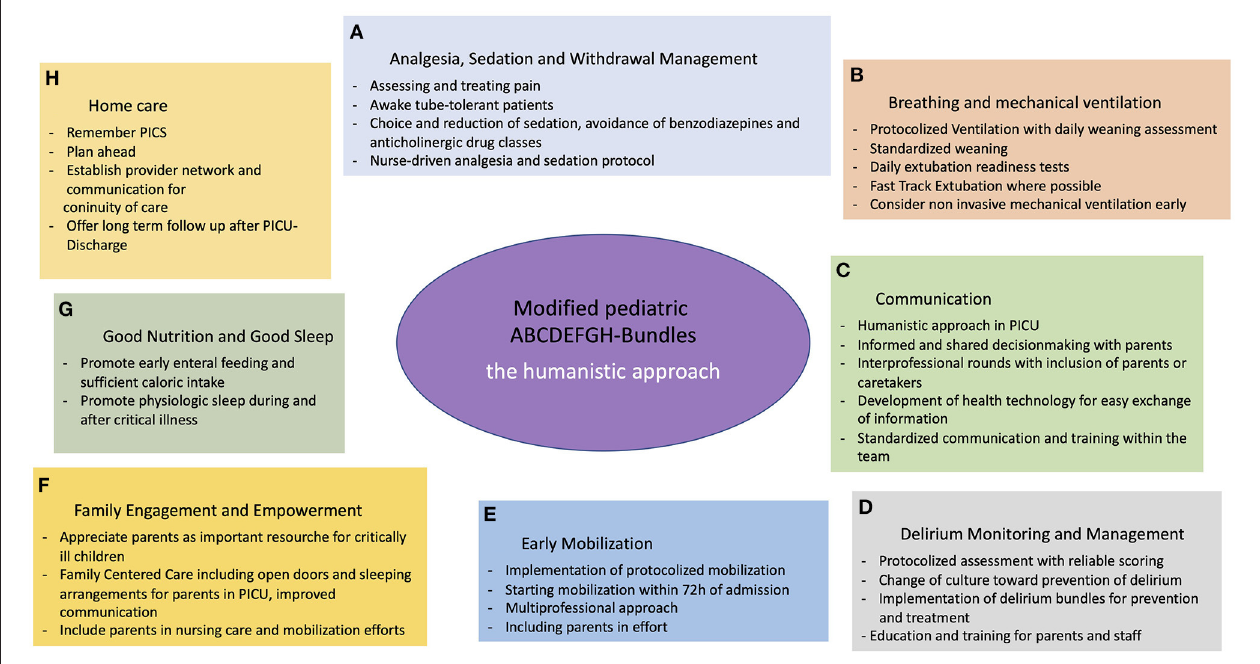
FIGURE 1 | Modified pediatric ABCDEFGH-bundles—the humanistic approach. (A) Analgesia and Sedation; (B) Breathing and mechanical ventilation; (C) Communication; (D) Delirium Monitoring and Management; (E) Early Mobilization; (F) Familie Engagement and Empowerment; (G) Good Nutrition and Good Sleep; (H) Home